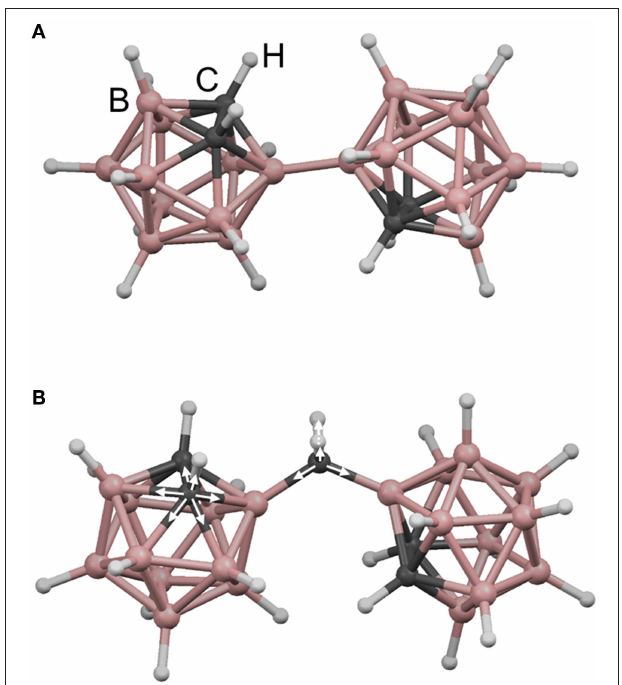
FIGURE 1 | Illustration of possible cross-linking modes in amorphous hydrogenated boron carbide (a-BC:H): (A) directly between icosahedra and (B) via intericosahedral carbon. In (B) are shown both 6-fold-coordinate intraicosahedral carbon and 4-fold-coordinate extraicosahedral carbon environments.